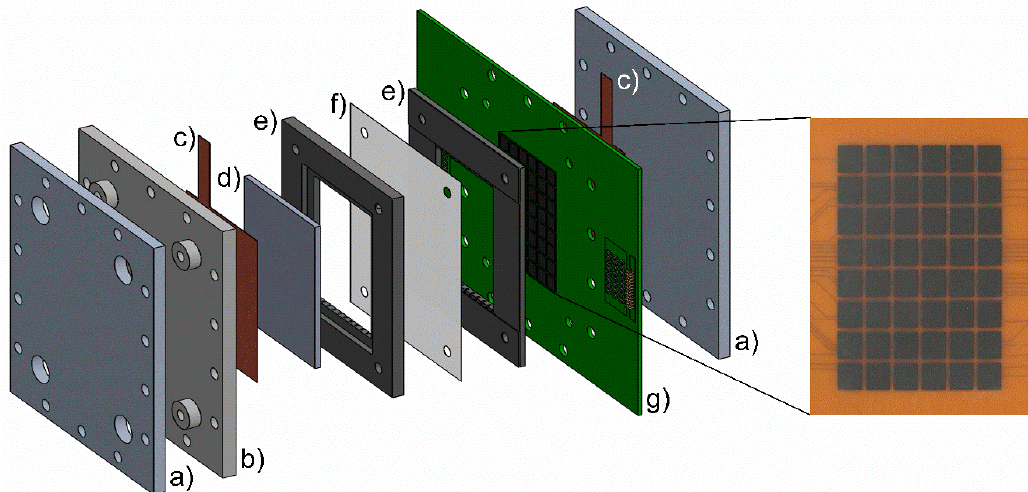
Figure 8. Experimental setup of the 40 cm² laboratory test cell with integrated segmented electrode on the printed circuit board and a detailed picture of the segmented electrode. The test cell configuration consists of the end plates ( a ), the isolation plate ( b ), the external current collectors ( c ), the bipolar plate ( d ), the flow frames ( e ), the separator ( f ), and the printed circuit board electrode ( g ). Not shown are the porous electrode and the flat sealings.